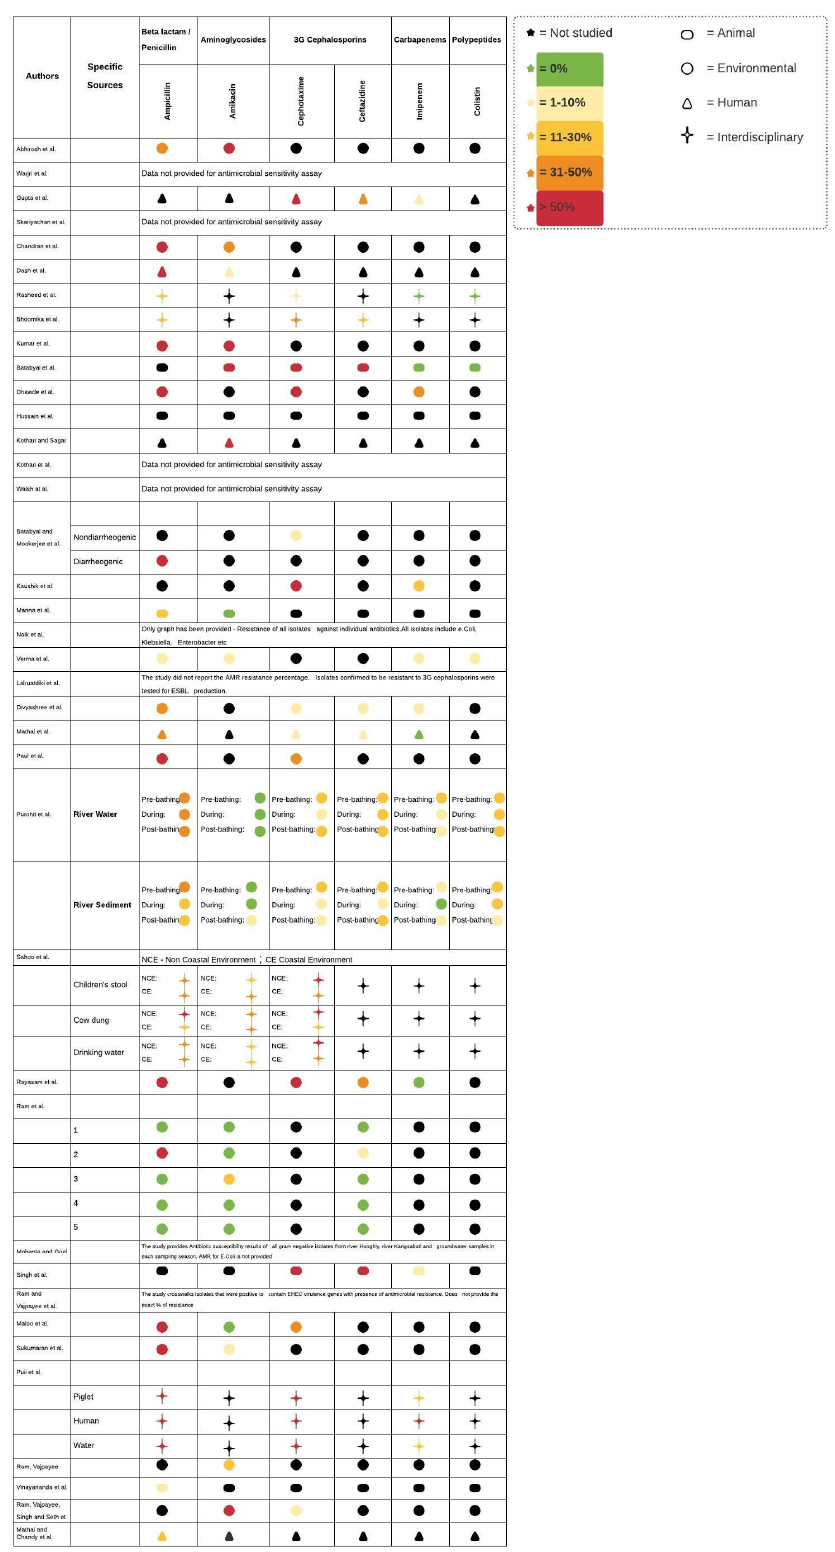
Figure 2. Antibiotic susceptibilities of E. coli in India—a review of the literature. This figure tabulates the prevalence of antimicrobial resistance in E. coli for six drugs that have high clinical relevance. The color codes indicate the percent resistance of isolates against individual antibiotics. The shape represents the source from which the AR-E were